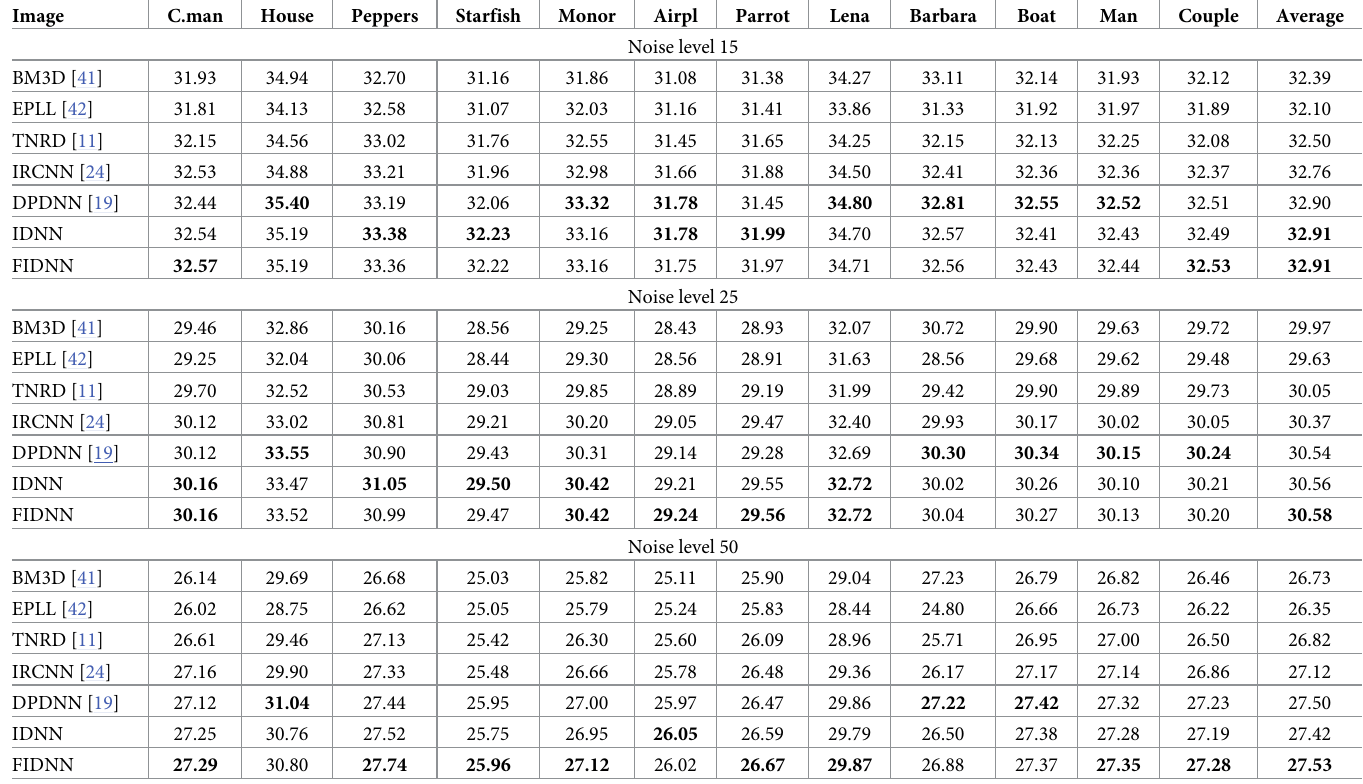
Table 3. PSNR results of denoising by different methods on Set12 dataset. Image